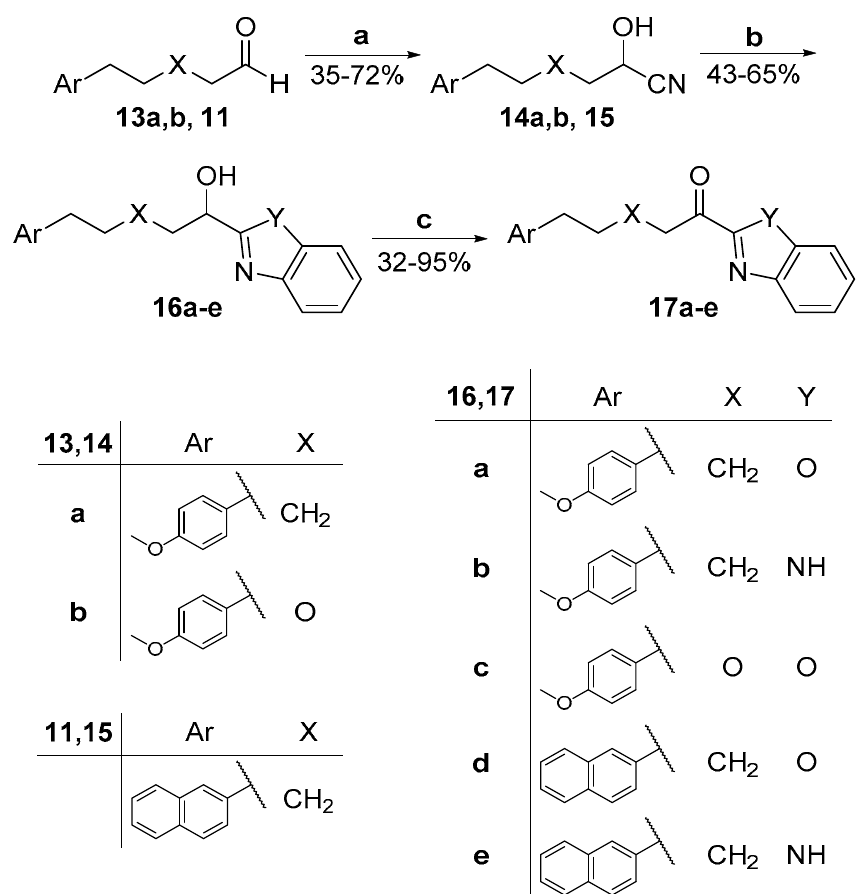
Figure 6. Synthesis of α -ketobenzoxazoles 17a,c,d and α -ketobenzimidazoles 17b,e . (a) (i) NaHSO 3 , CH 2 Cl 2 ; (ii) KCN, H 2 O; (b) (i) CH 3 COCl, CHCl 3 /absolute EtOH; (ii) 2-aminophenol or 2-phenylene- diamine, absolute EtOH; (c) Dess–Martin periodinane, CH 2 Cl 2